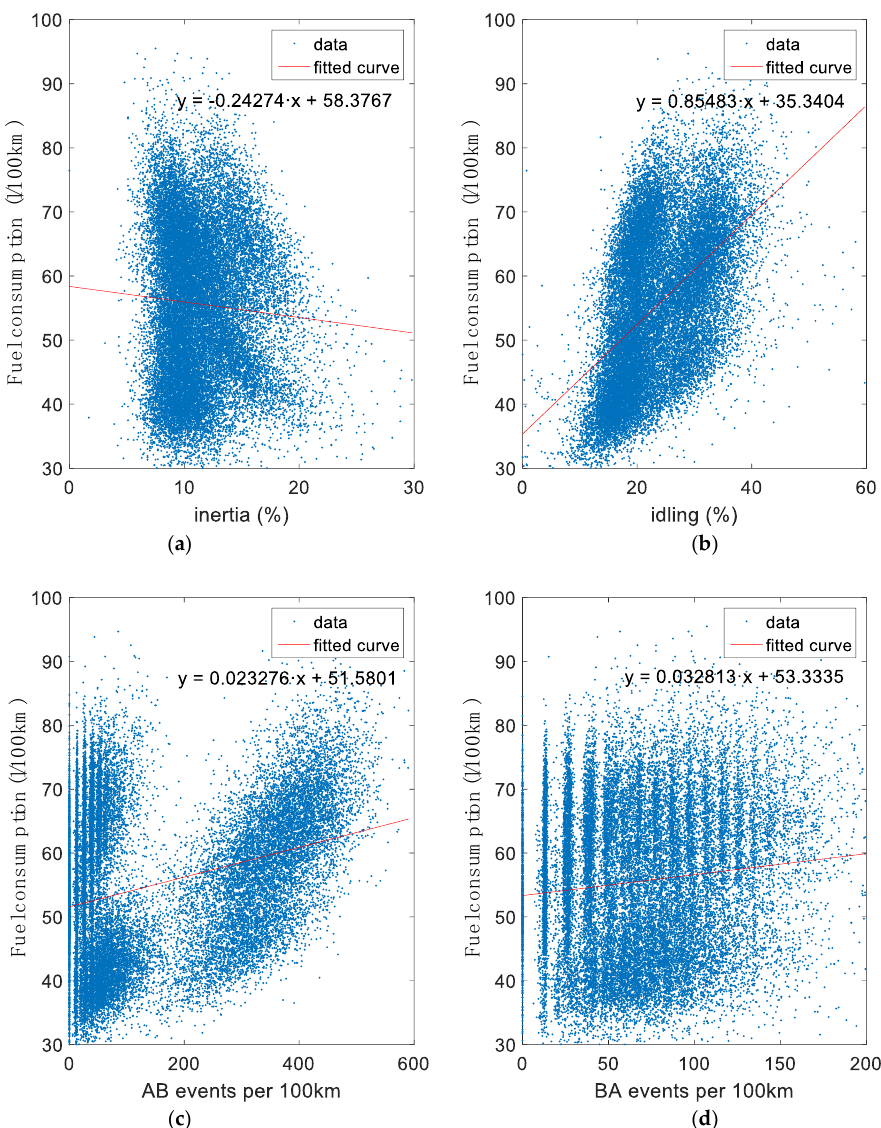
Figure 7. Influence of the efficient patterns on fuel consumption. ( a ) Fuel consumption vs. inertia pattern; ( b ) Fuel consumption vs. idling pattern; ( c ) Fuel consumption vs. AB pattern; ( d ) Fuel consumption vs. BA pattern.